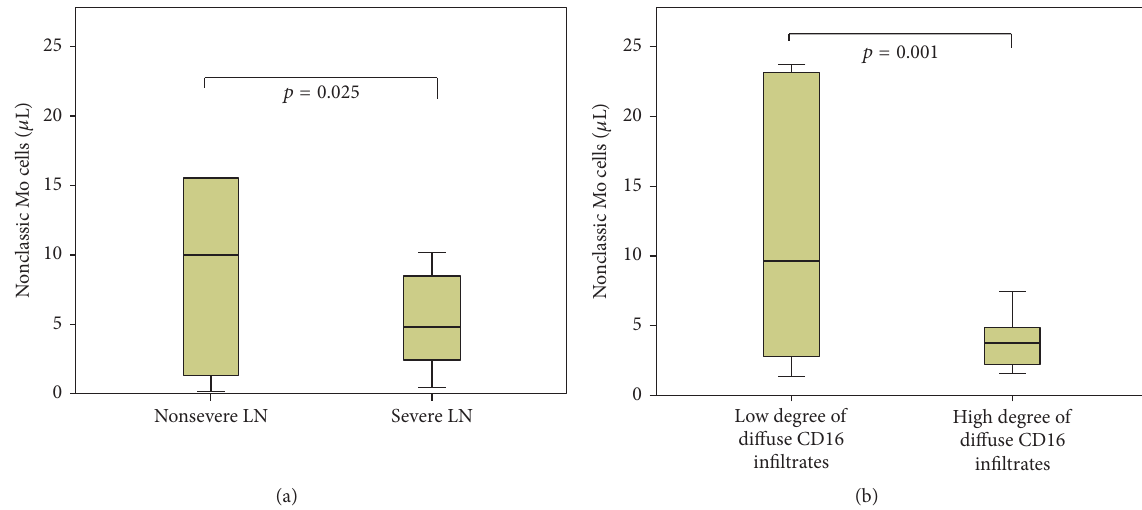
Figure 2: Peripheral blood levels of Mo subsets according to severity of LN (a) and degree of infiltrations by CD16 + cells (b).